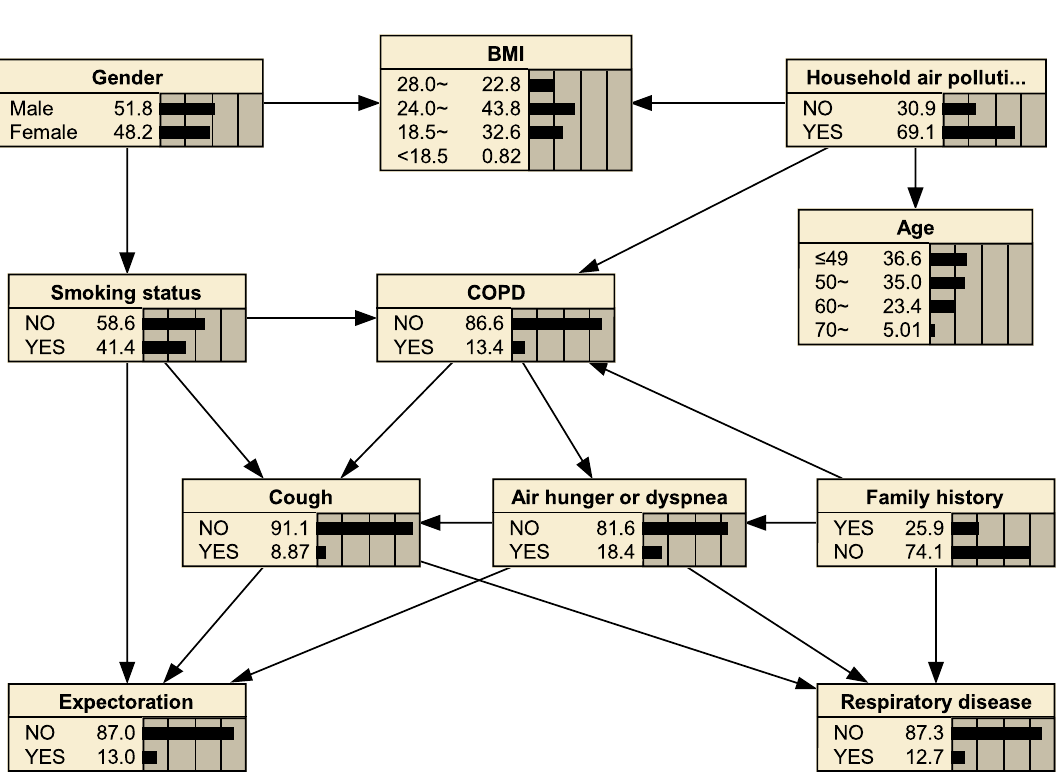
Figure 2. MMHC algorithm to construct COPD Bayesian networks and prior